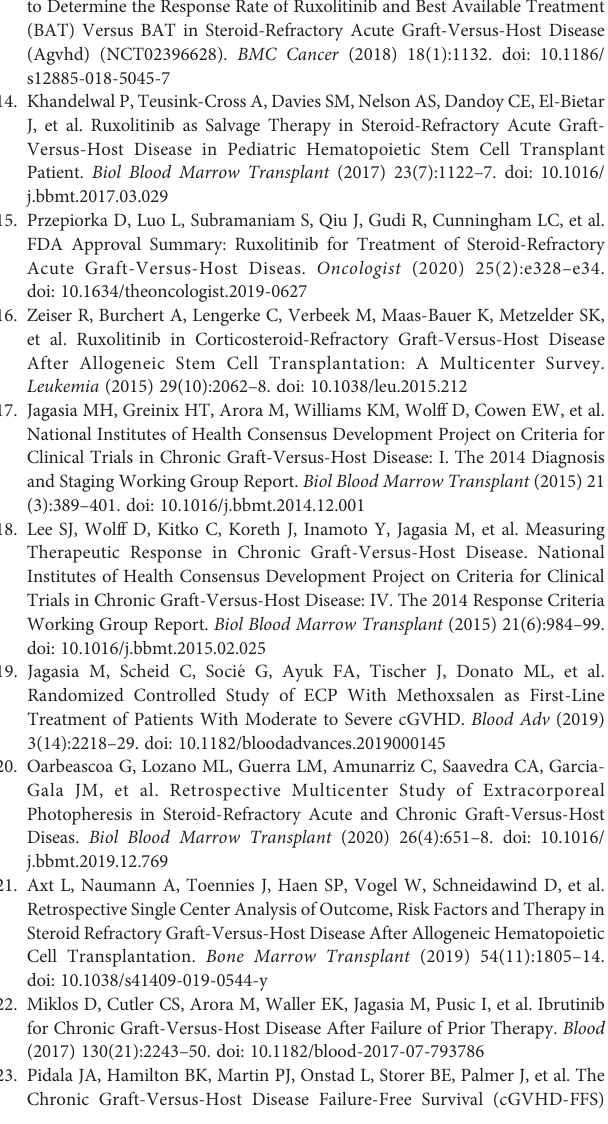
Supplementary Figure 1 | Comparison of different lymphocyte subsets and cytokine levels in different organs before and after treatment with ruxolitinib. (A) Comparison of different lymphocyte cell subsets in different organs. (B) Comparison of different B cell subsets in different organs. (C) Comparison of different cytokine levels in different organs. Paired sample t test was used for the analysis. The numbers of patients are indicated in each